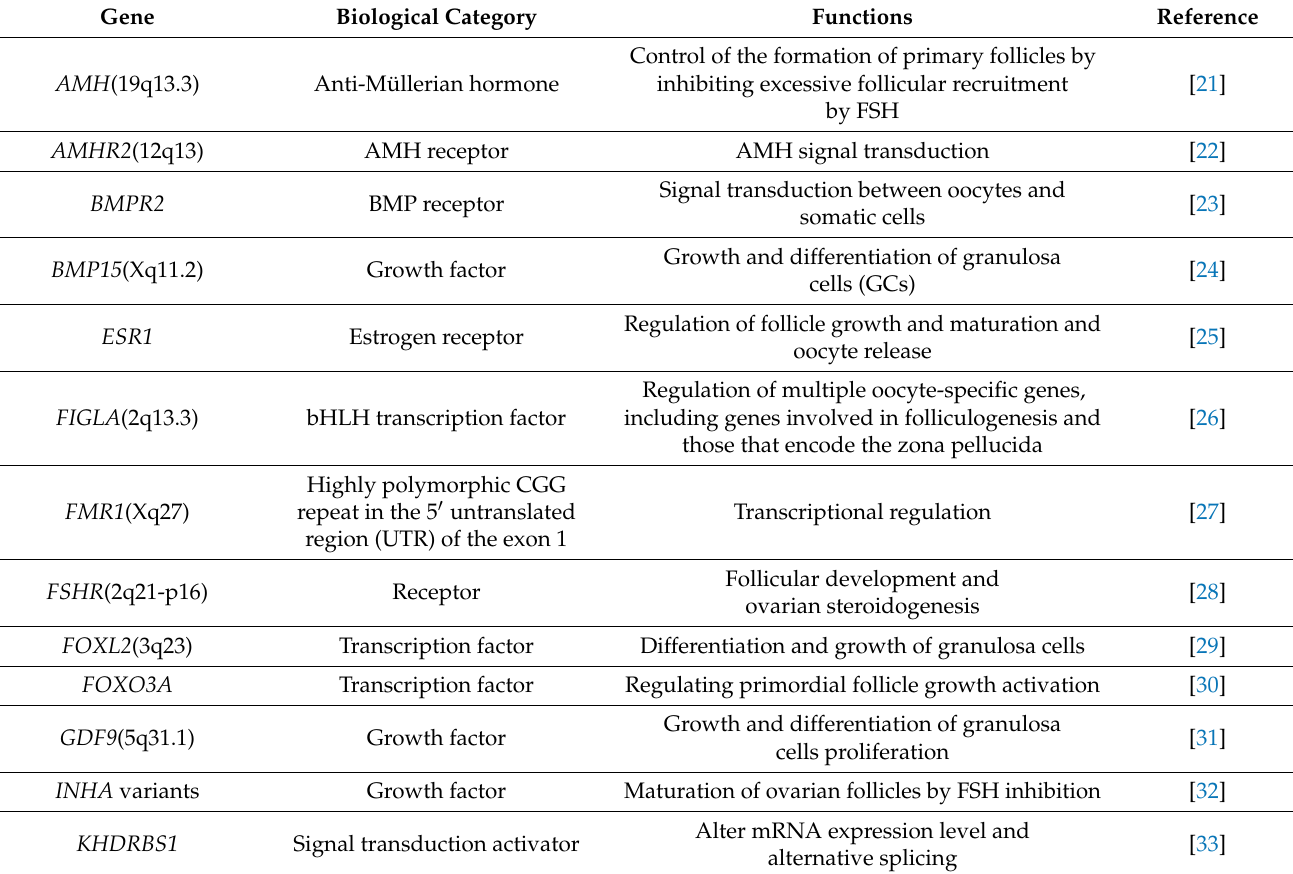
Table 1. List of genes related to premature ovarian inefficiency (POI) from previous studies. Gene Biological Category